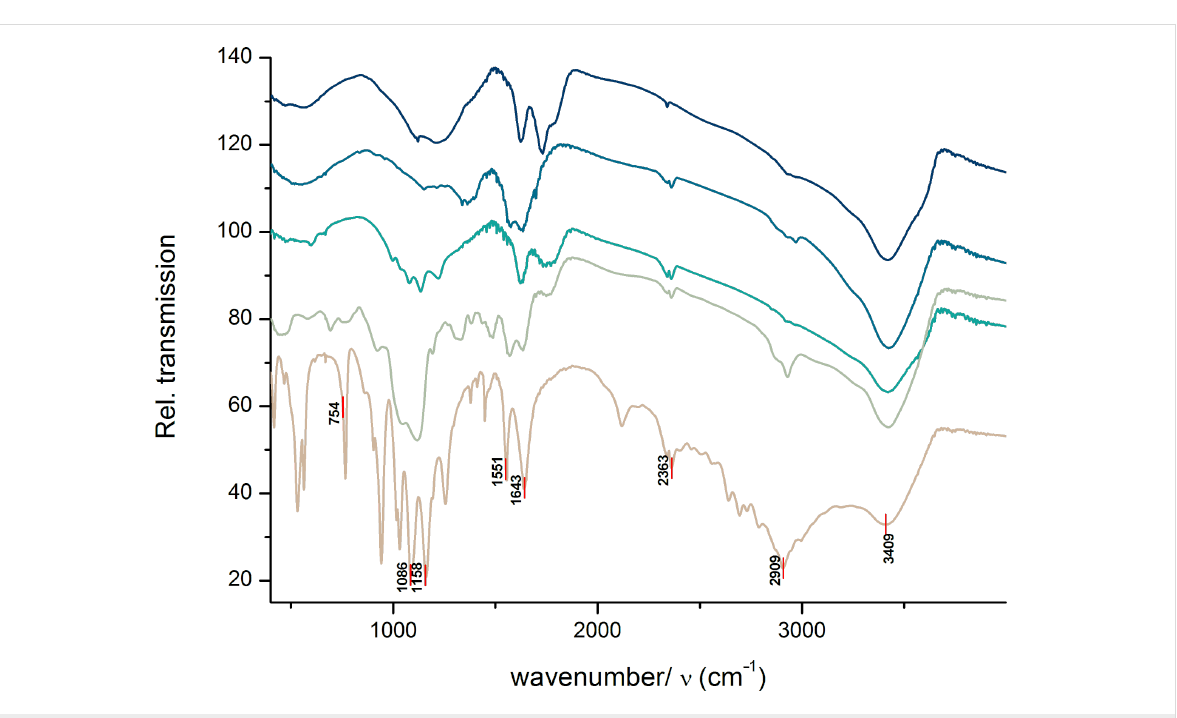
Figure 3: ATR-FTIR spectra of species involved in the synthesis process, from Scheme 1.